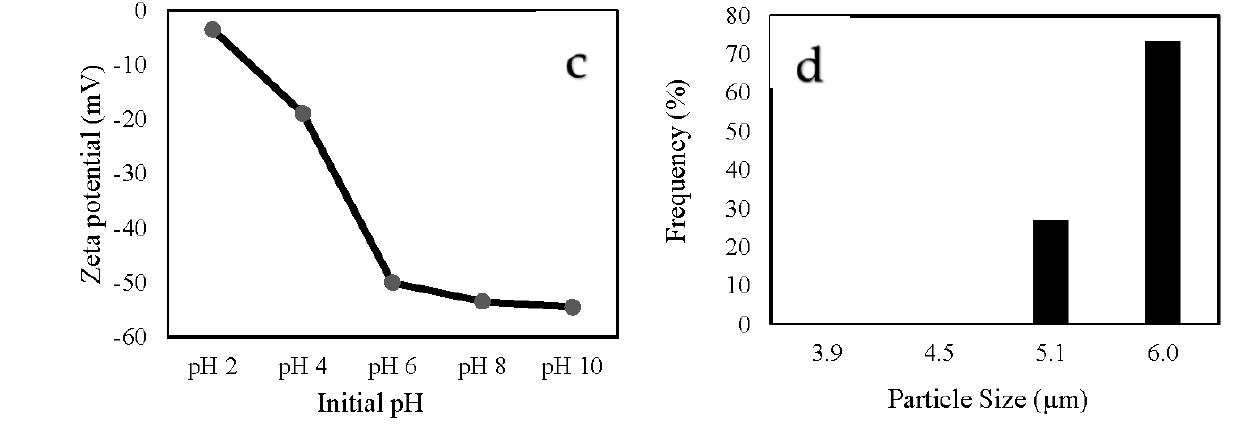
Figure 1. Characterization of C-ZLCH. ( a ) SEM photograph. ( b ) EDS spectra. ( c ) Zeta potential. ( d ) Particle size distribution.